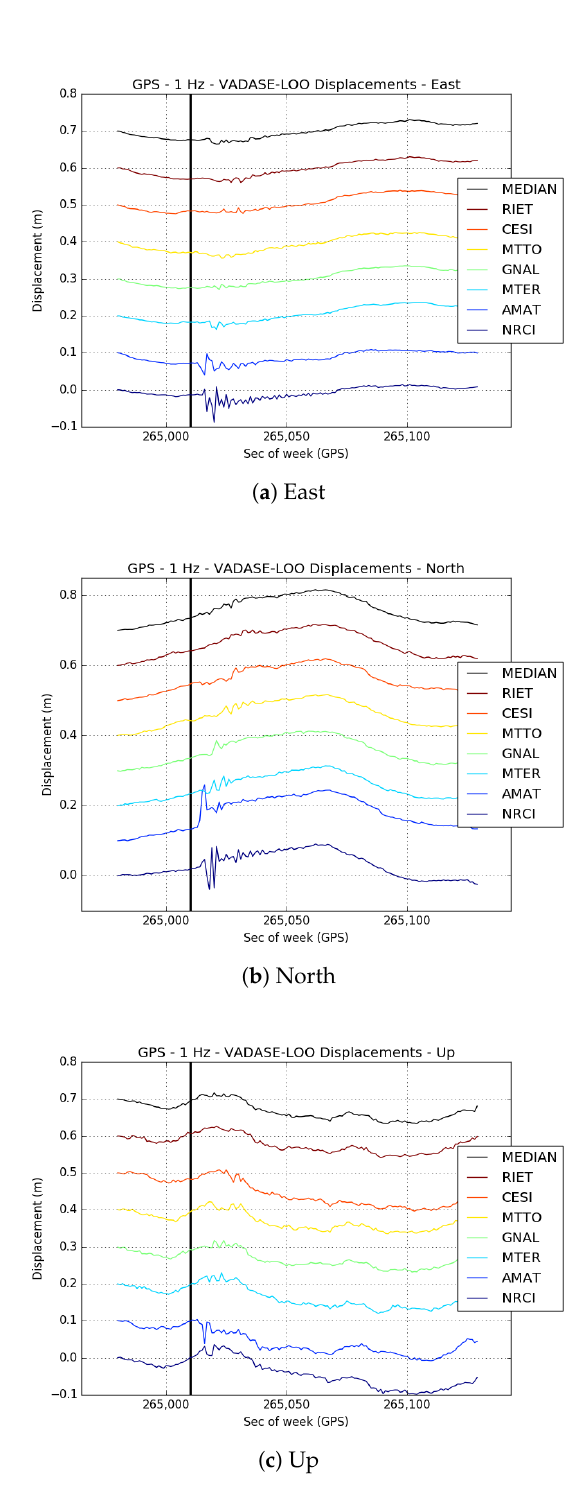
Figure 4. Estimated displacements by VADASE-LOO for the 150-s interval across the 24 August 2016 main shock (GPS